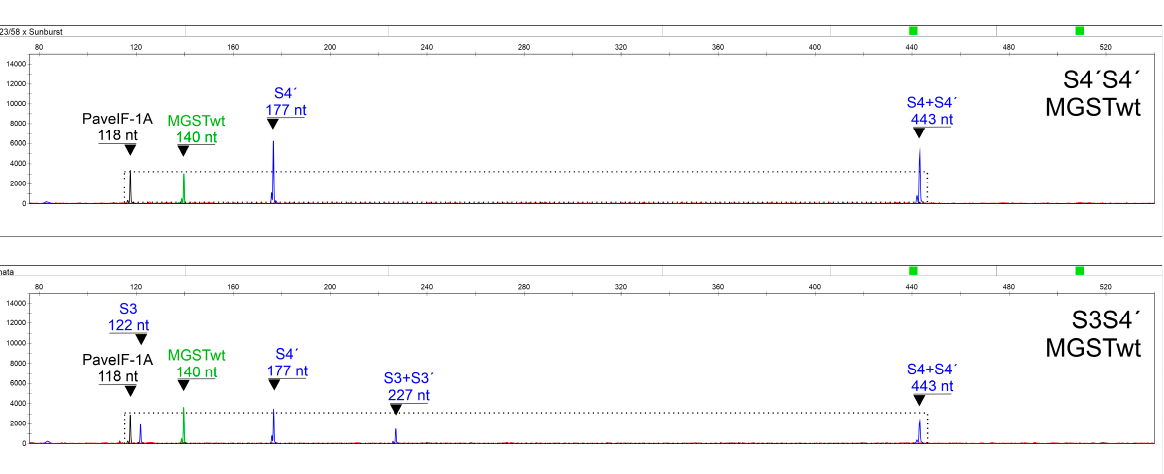
Figure 5. A representative output of fragment analysis for S3 ′ S3 ′ and S3 ′ S4 as a prototype of S3 ′ Sx (cid:48) S3 (cid:48) andS3 (cid:48) S4asaprototypeofS3 (cid:48) Sxgenotypes. genotypes. Figure 5. ArepresentativeoutputoffragmentanalysisforS3 Similarly, for S4 (cid:48) S4 (cid:48) genotypes, the S4+S4 (cid:48) S-RNase fragment (443 nt; blue channel) and Similarly, for S4 ′ S4 ′ genotypes, the S4+S4 ′ S-RNase fragment (443 nt; blue channel) S4 (cid:48) SFB fragment (177 nt; blue channel) showed statistically significant differences between and S4 ′ SFB fragment (177 nt; blue channel) showed statistically signi fi cant di ff erences both genotype groups after their normalization to the PaveIF-1A fragment (118 nt; yellow between both genotype groups after their normalization to the PaveIF-1A fragment (118 channel), and there was no significant difference in the ratio of these peaks between groups nt; yellow channel), and there was no signi fi cant di ff erence in the ratio of these peaks be- (Figure 6, Table 6). tween groups (Figure 6, Table 6).